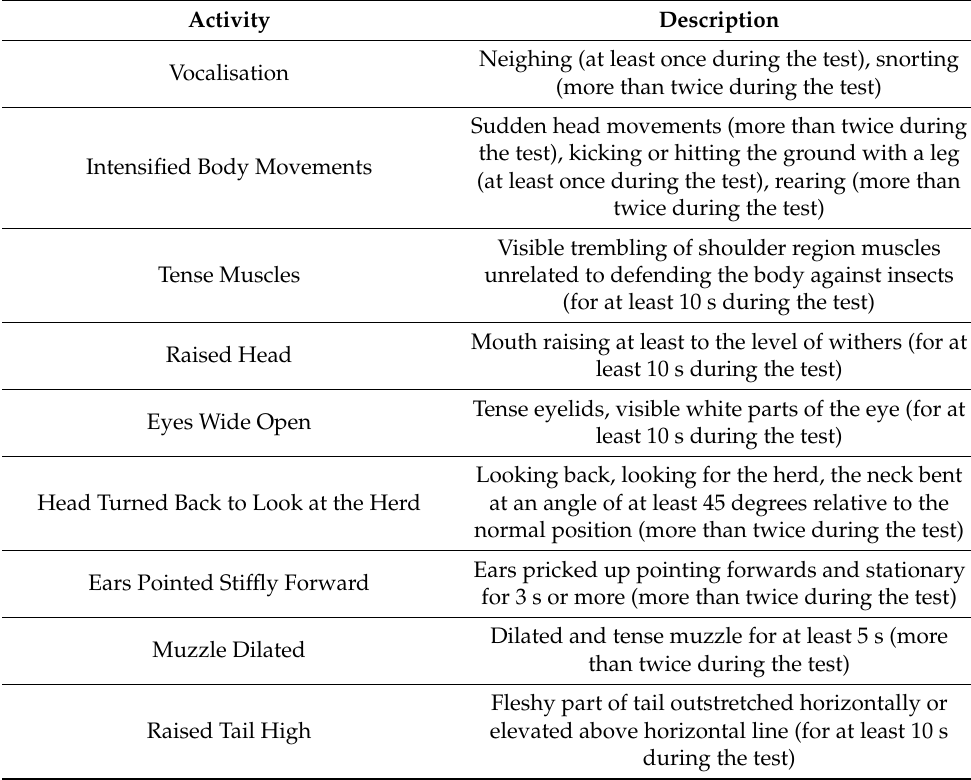
Table 2. Activities measured in social isolation